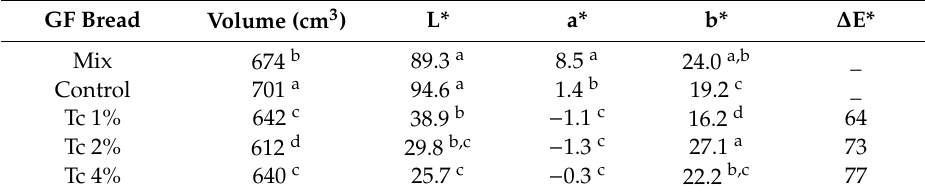
Table 4. Bread volume and colour parameters obtained for bread crumb. Mix, Control and GF dough with T. chuii Tc 1%, Tc 2% and Tc 4%. Di ff erent letters in the same column correspond to significant di ff erences ( p <